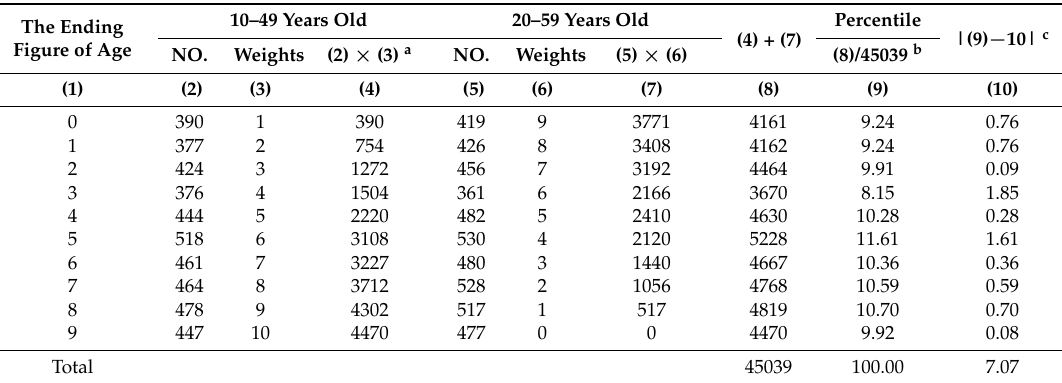
Table 1. Myers blended index of Jiangxi province in